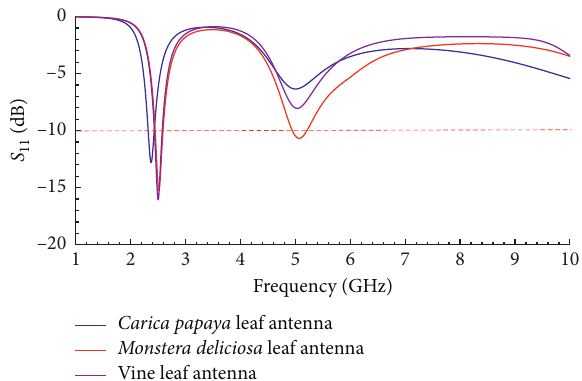
Figure 5: The S 11 of Slitless full-ground width BioAs-MPAs configurations.